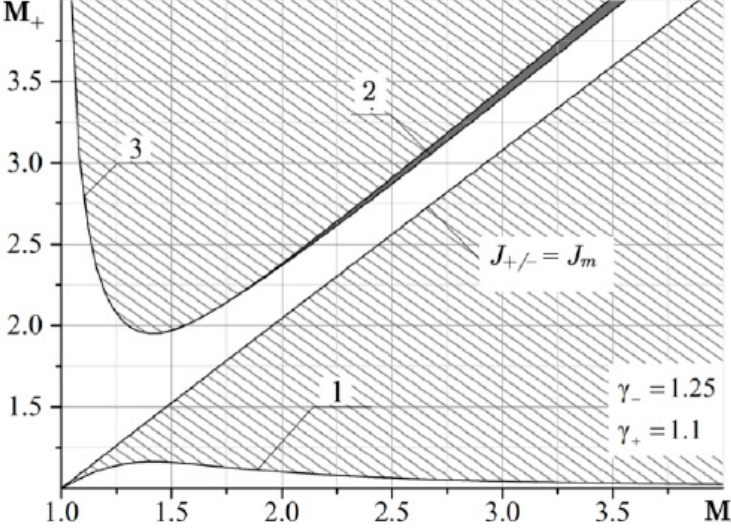
Figure 7. The domains of existence of characteristic refraction at the interface between the hot hydrocarbon fuel mixture ( γ = 1.1) and the products of its combustion ( γ = 1.25), where domains 1, 2 and 3 are the first, second and third roots of Equation (8).